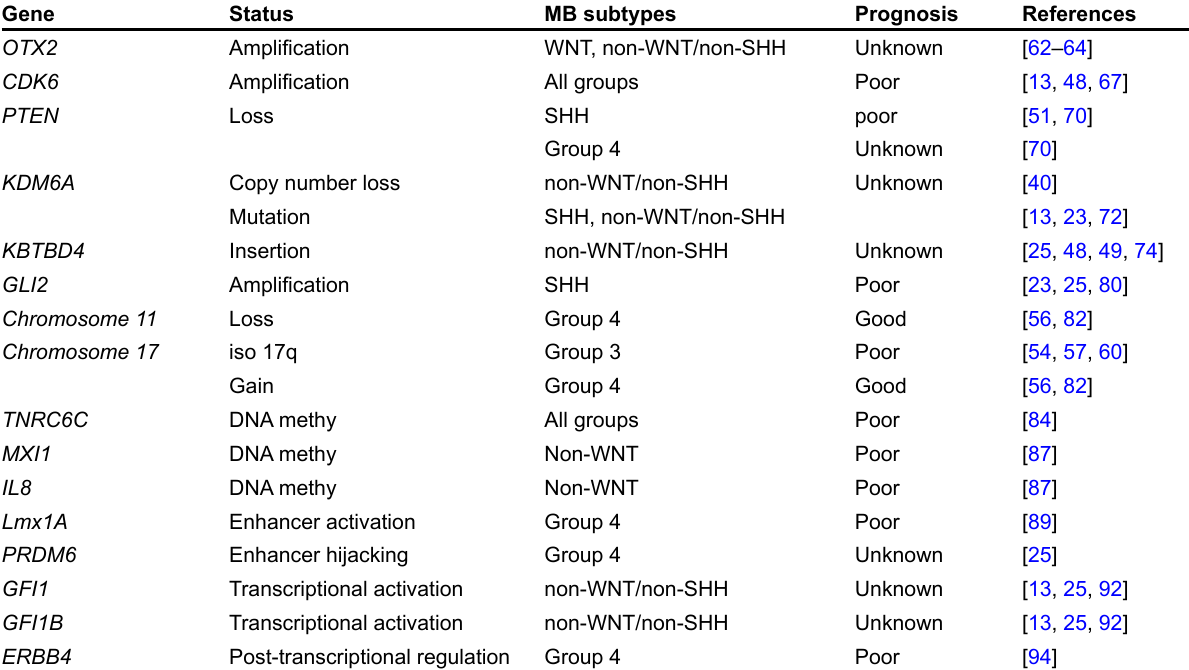
Table 2. Summary of molecular pathology markers in MB ( continued )